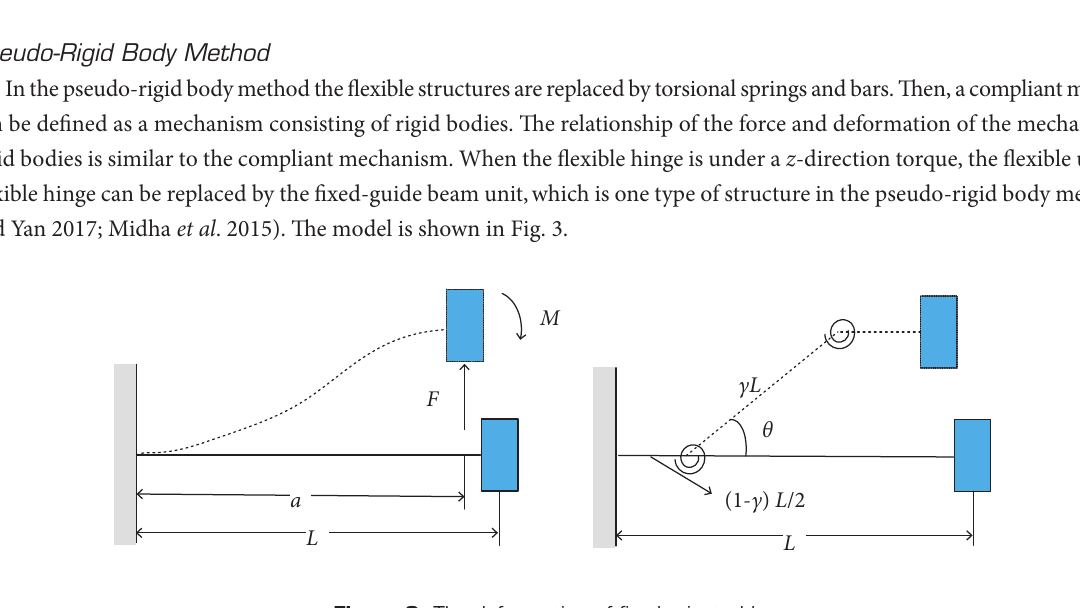
Figure 3. The deformation of fixed-oriented beam.